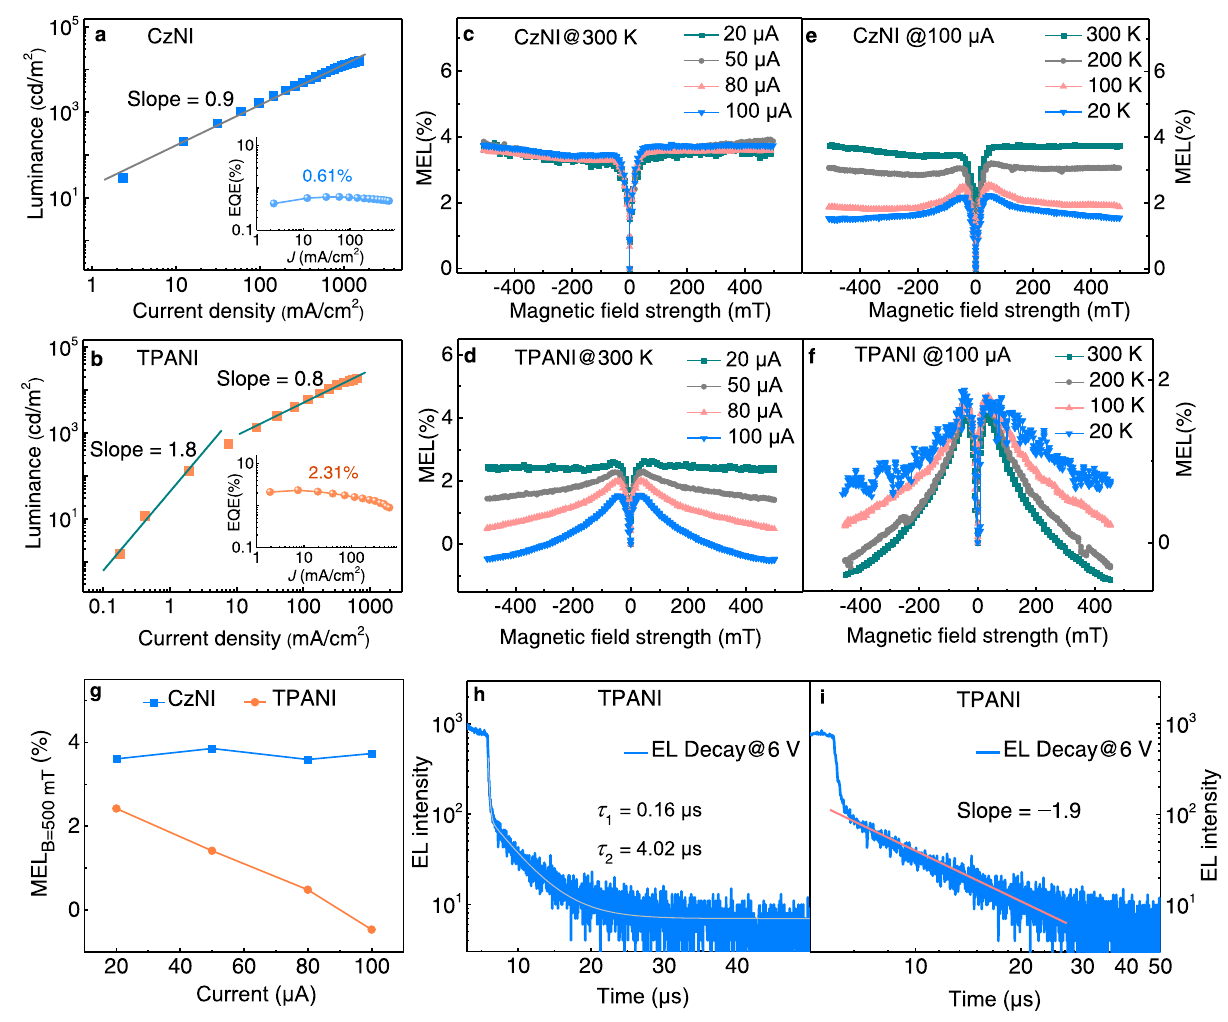
Fig. 4 | EL characteristics. a , b Luminance as a function of current density (insets: external quantum ef fi ciency (EQE) as a function of current density ( J ) for devices). c , d Magneto-electroluminescence (MEL) response at different current density at room temperature. e , f MEL response at 100 μ A at different temperatures. g The amplitudes of MEL response at 500mT versus the